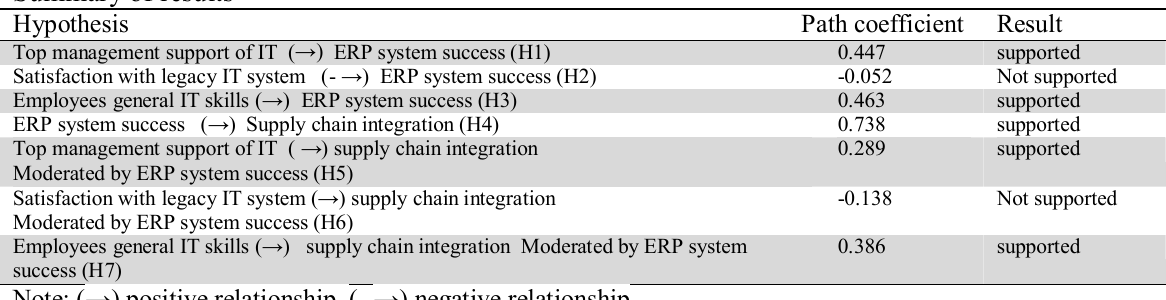
Summary of results